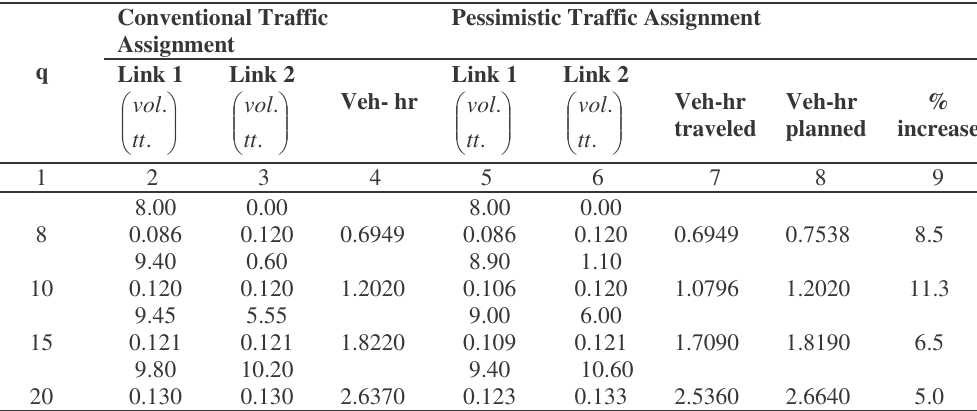
Table 1. The results of UEF and PEF traffic